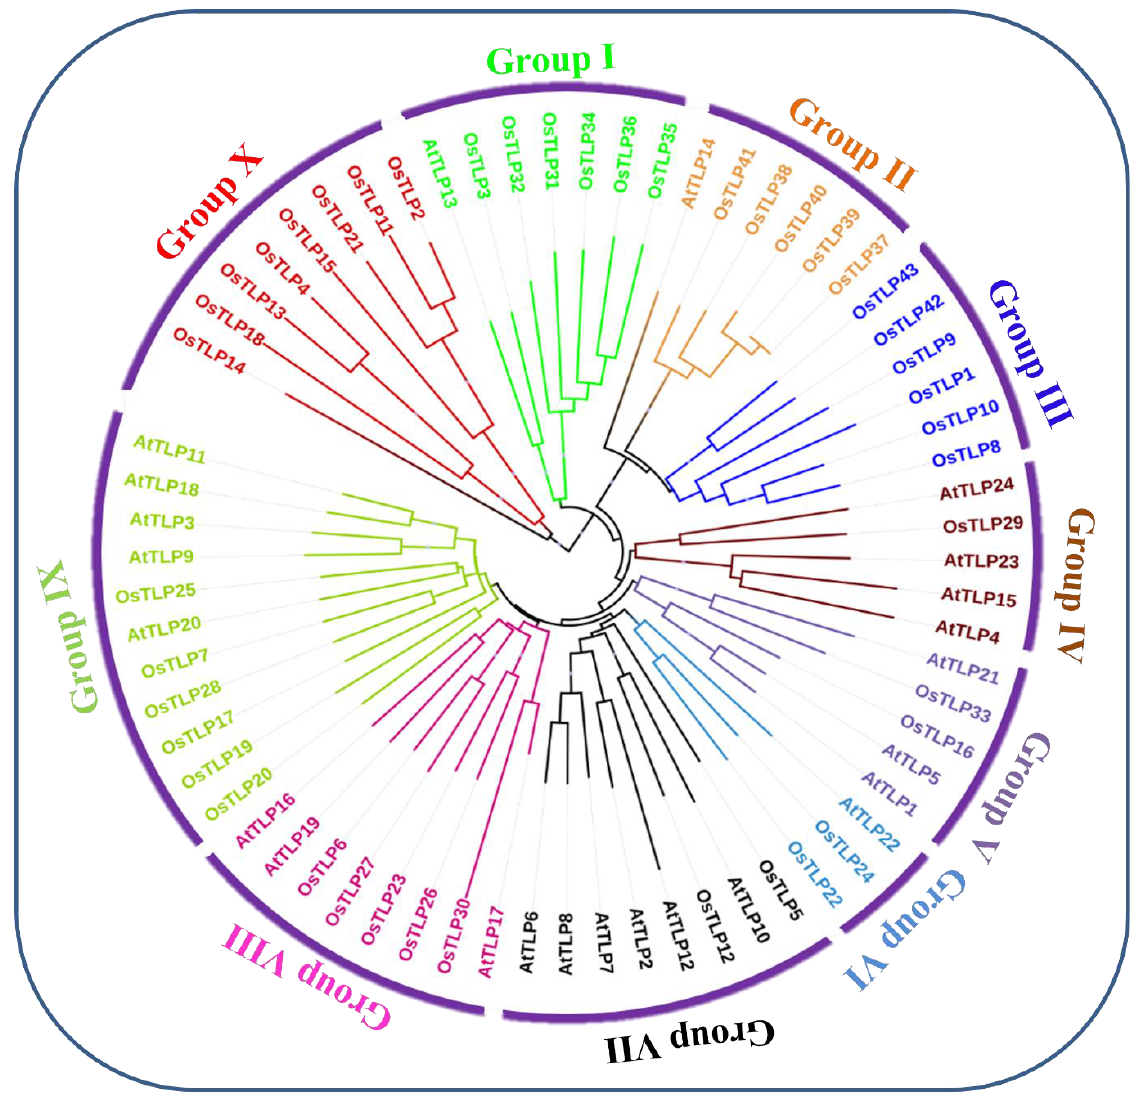
Figure 1. Phylogenetic analysis of TLP. The phylogenetic tree was generated using the amino-acid sequences of selected TLPs via NJ methods. All O. sativa TLPs and their A. thaliana counterparts were classified into 10 groups.